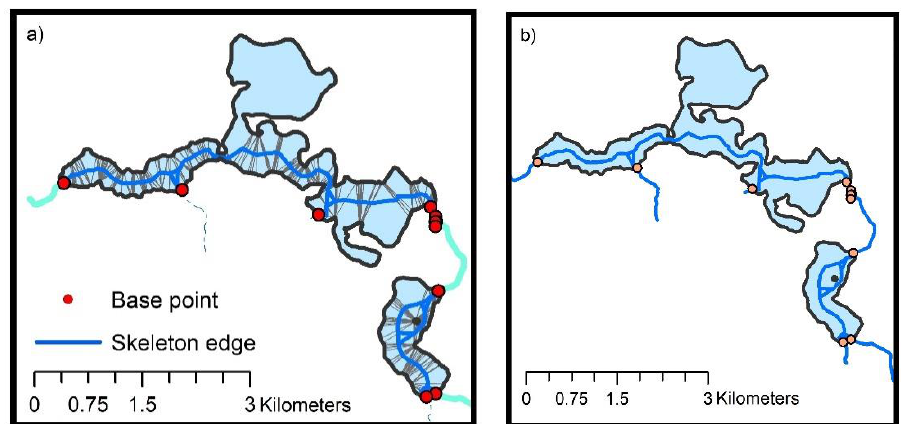
Figure 19. Skeleton of the hydrographic network generated based on 11 base points in four lakes, one river intersecting all lakes, and three seasonal streams flowing into the analyzed lakes: ( a ) generation process; ( b ) results.